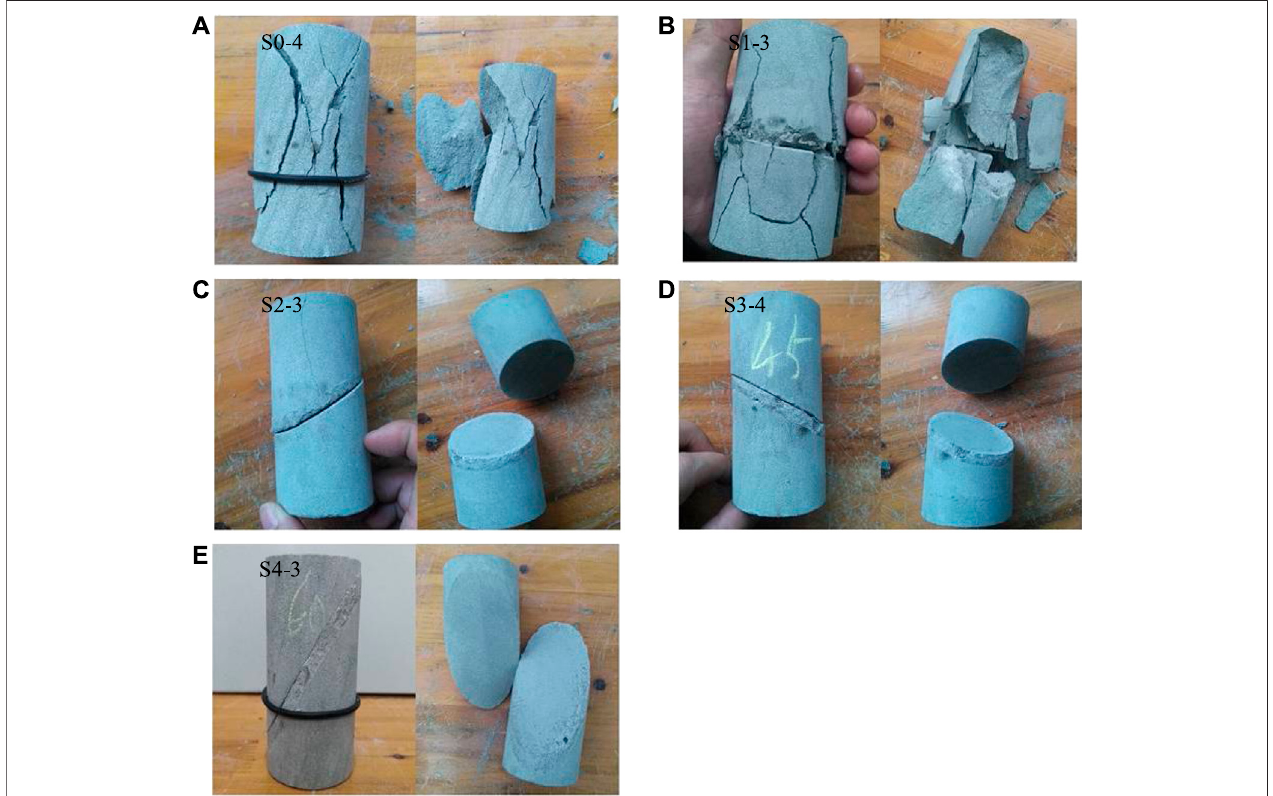
FIGURE 14 | Failure mode of